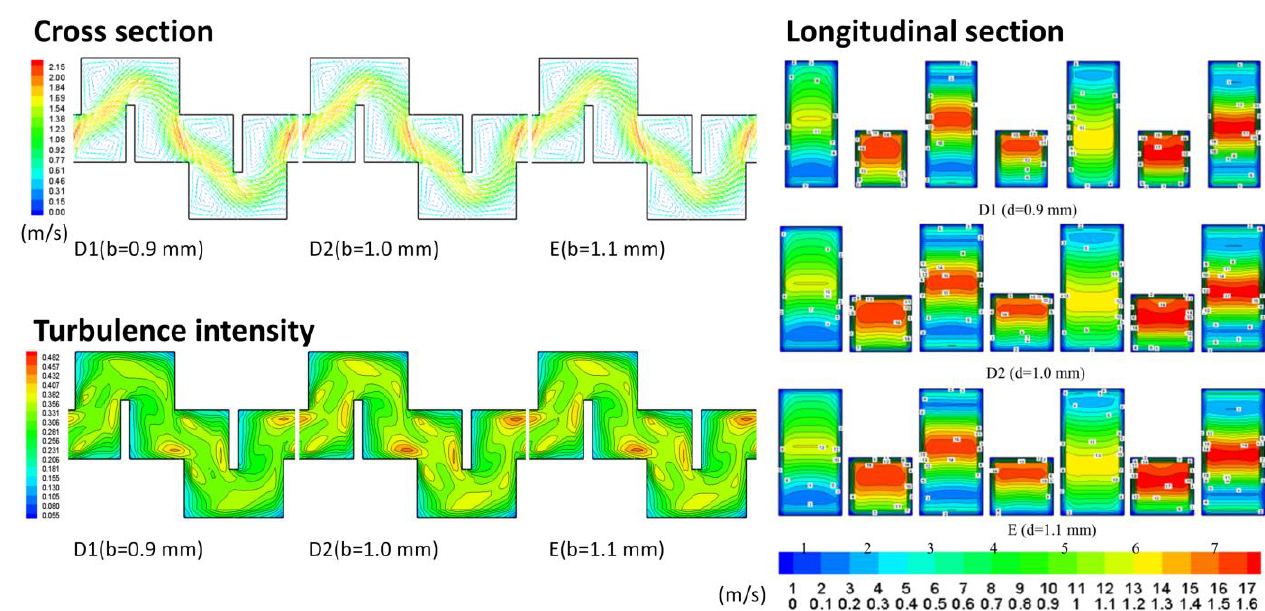
Figure 9. Analysis of transverse and longitudinal velocity field distribution and turbulence intensity characteristics of flow paths of different depths.